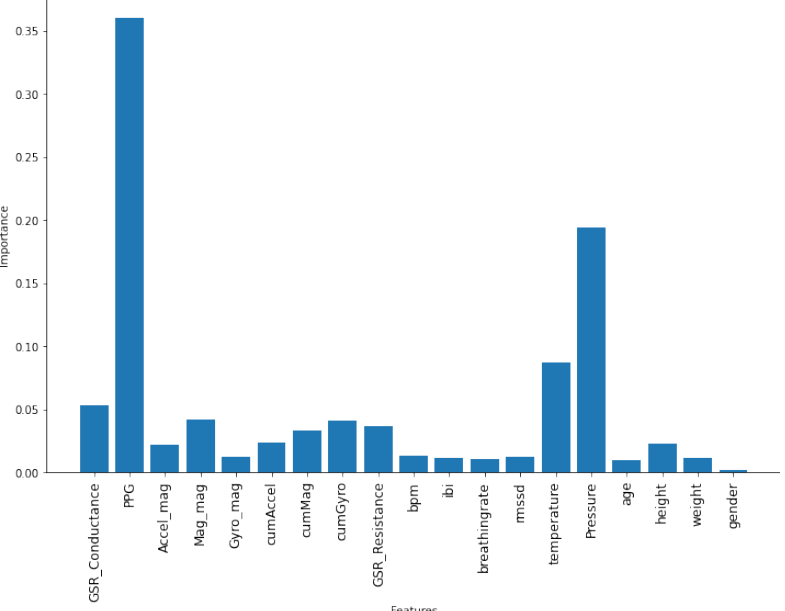
Figure 7. Features’ importance with random